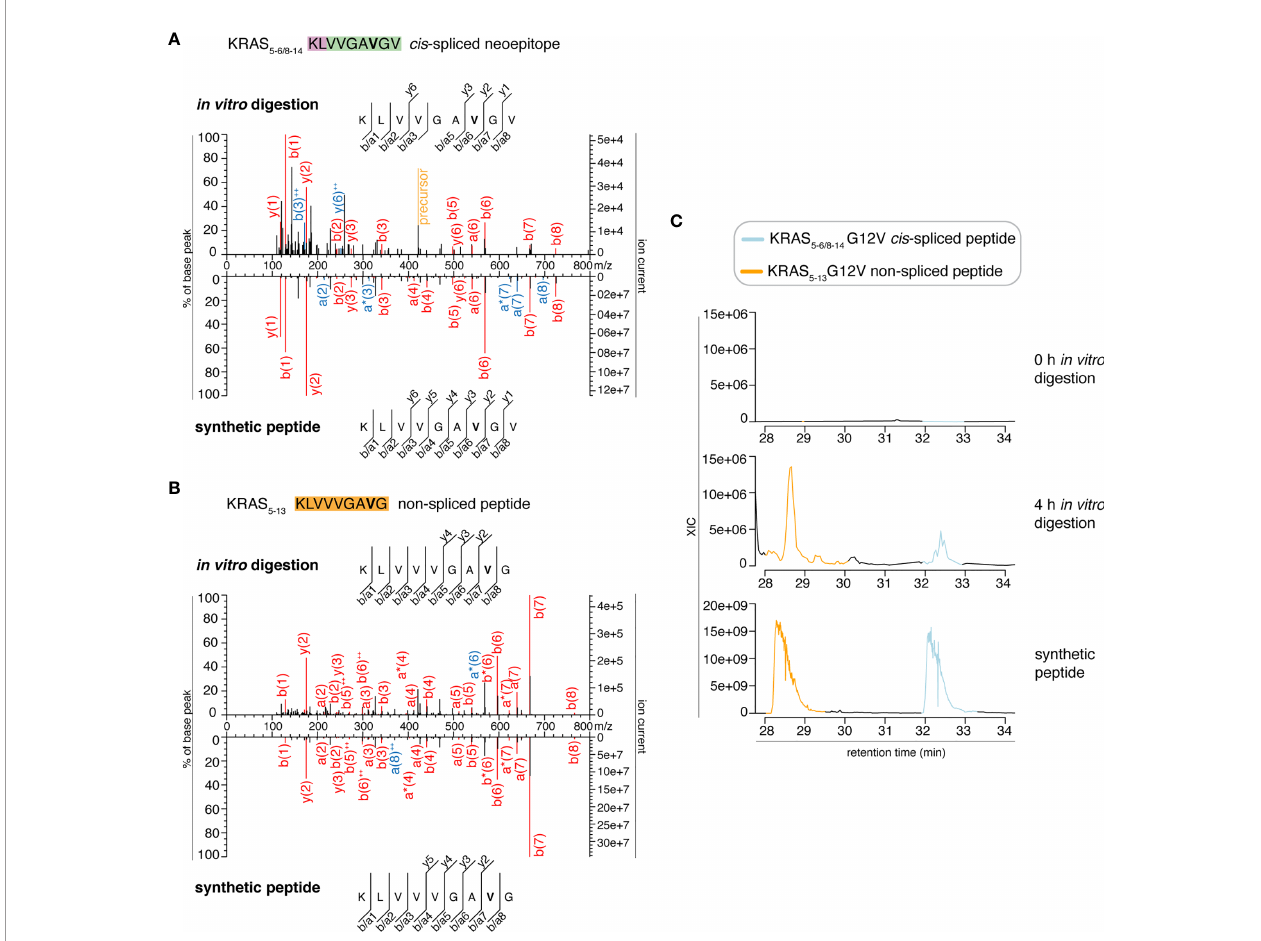
FIGURE 2 | MS2 spectra of the KRAS 5-6/8-14 G12V cis -spliced and KRAS 5-13 G12V non-spliced peptides by standard MS through Exploris 480 Orbitrap. (A, B) MS2 spectra of the KRAS shown with the corresponding b-, a- and y-ions identi fi ed. The G12V mutation is depicted in bold. In the spectra, assigned peaks for b-, a- and y-ions are reported in color. Ion neutral loss of ammonia and double charged ions are symbolized by * and ++ , respectively. Red marked peaks are assigned in MS2 spectra of both in vitro digestions and synthetic peptides, whereas blue marked peaks are assigned only in one of the two spectra. We marked the doubly charged peptide precursor in yellow. (C) Extracted ion chromatograms for the target peptides in the 0 h and 4 h in vitro digestion and the synthetic counterpart are plotted and indicate matching RTs and absence of a biologically signi fi cant peak in the 0 h digestion. MS ion chromatograms correspond to the m/z = 421.275 – 421.875. In (A – C) samples correspond to MF series carried out in HMDA buffer and have been measured through standard MS by Orbitrap Exploris 480 mass